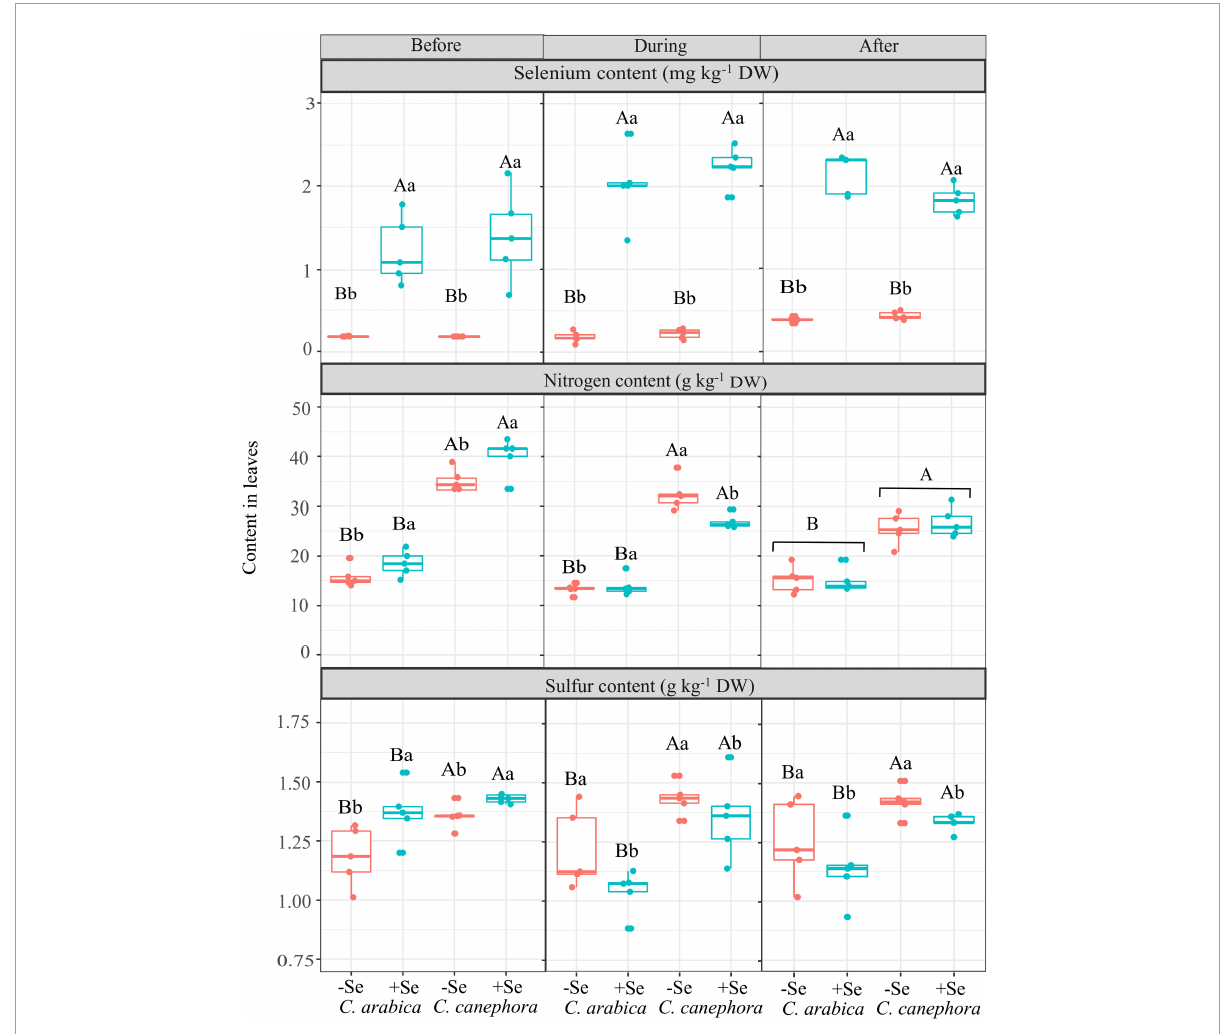
FIGURE2 Effects of Se foliar application and temperature condition on Se, S, and N content in leaves of C. arabica and C. canephora . Mean values followed by different lowercase letters within Se supply conditions (with selenium and without Se) in each genotype are significantly different ( p < 0.05, n = 5) by Tukey multiple comparison tests as well as different uppercase letters that indicate significant differences in species ( C. arabica and C. canephora ). Vertical bars represent the standard